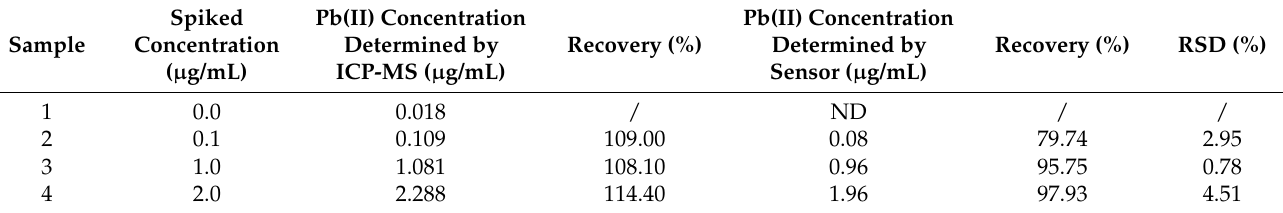
Table 1. Determination of Pb (II) in three mantis shrimp samples ( n = 3).